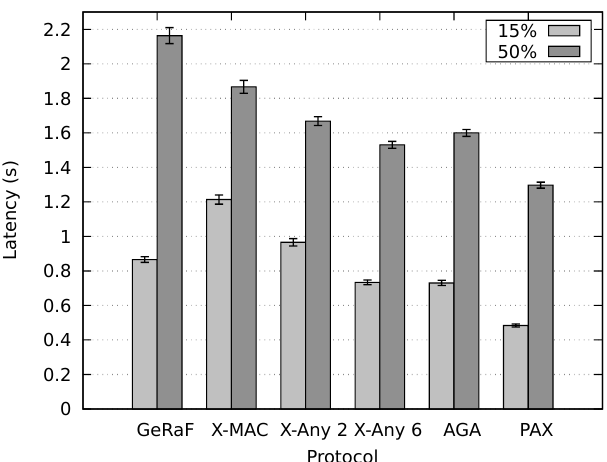
Figure 11. End-to-end latency for concurrent flows transmitted in non-persistent mode, for data packet durations t data = 50% t cycle and t data = 15% t cycle , SD = 650 m.